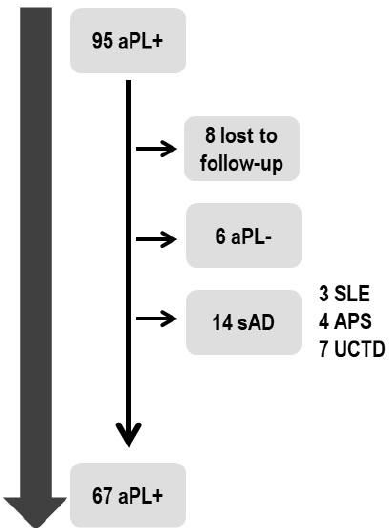
Figure 1. Clinical evolution of aPL carriers enrolled in the present analysis (N of subjects = 95). Legend: aPL (antiphospholipid antibodies); sAD (systemic Autoimmune Diseasese); SLE (Systemic Lupus Erythematosus); UCTD (Undifferentiated Connective Tissue Diseases).